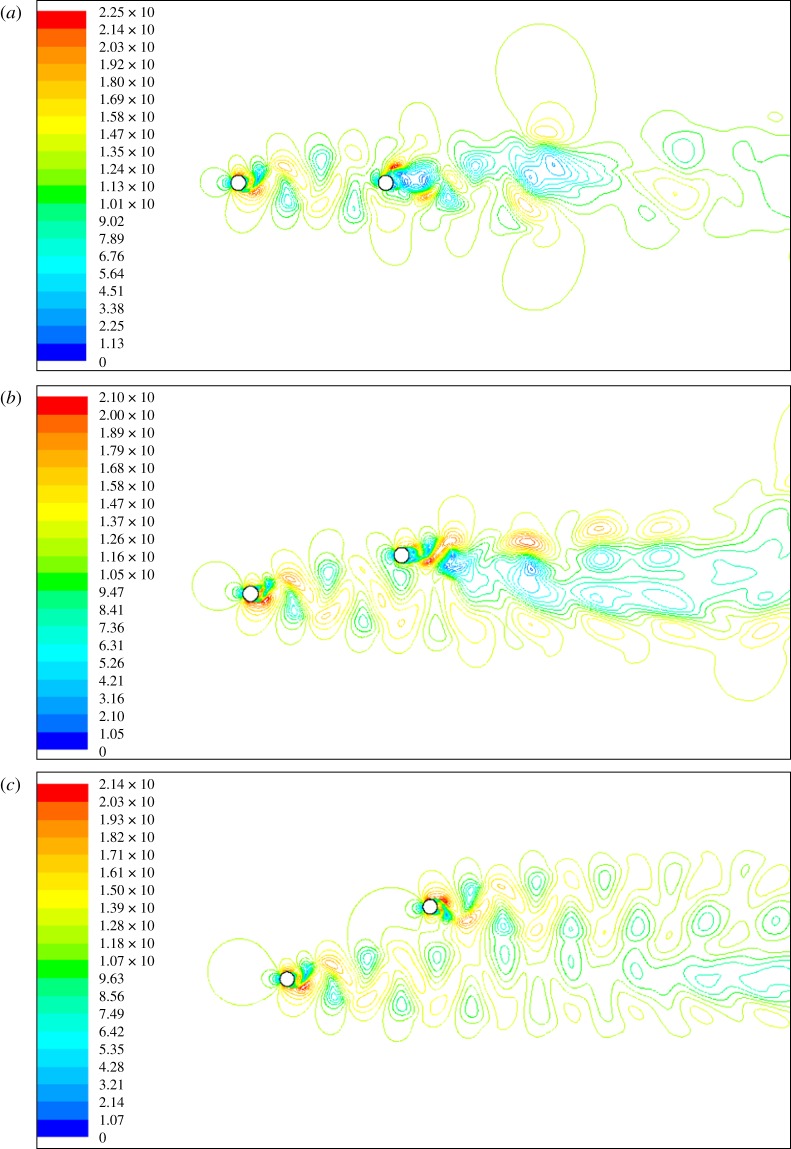
Velocity contours of air flow around a twin bundle conductor. (a) Y = 10D and Z = 0. (b) Y = 10D and Z = 2.5D. (c) Y = 10D and Z = 5D.